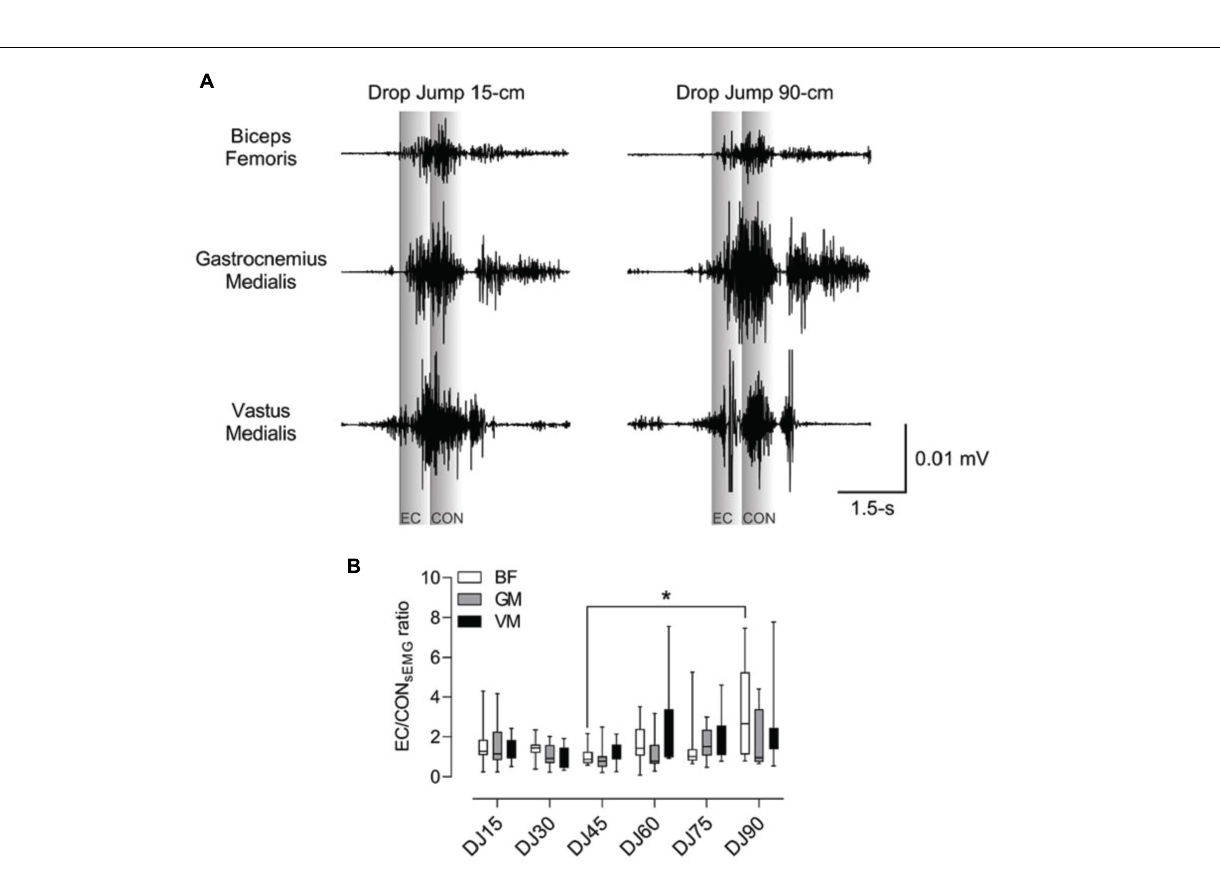
TABLE 2 | Comparison of drop jump performance variables and surface electromyography (%MVC) between drop heights. DJ15 DJ30 DJ45 DJ60 DJ75 DJ90 ANOVA outcomes Contact time (ms)